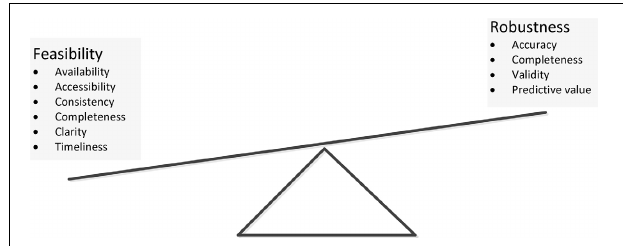
FIGURE 1 | Data properties for medication adherence data